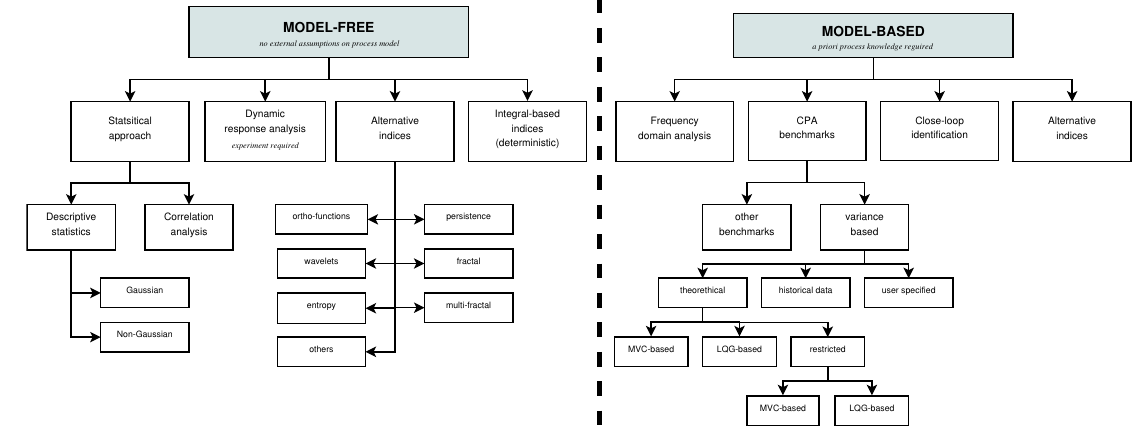
Figure 4. CPA techniques